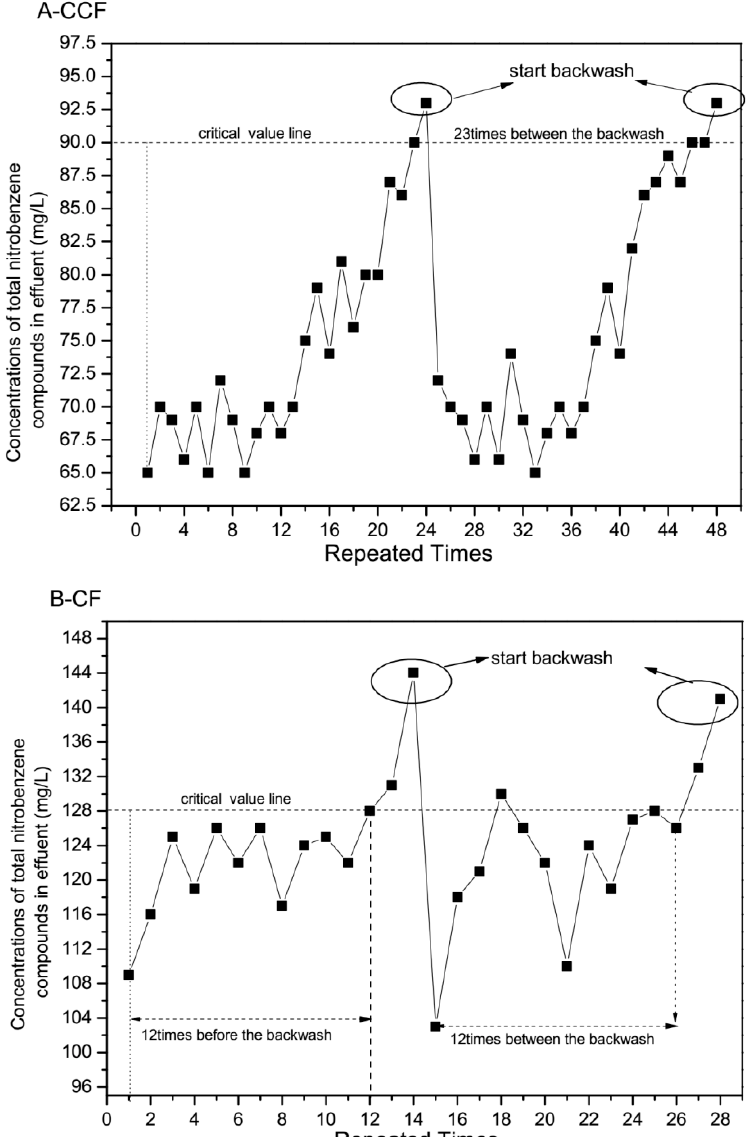
Figure 5. The backwash frequency of the optimum iron-based catalyst.